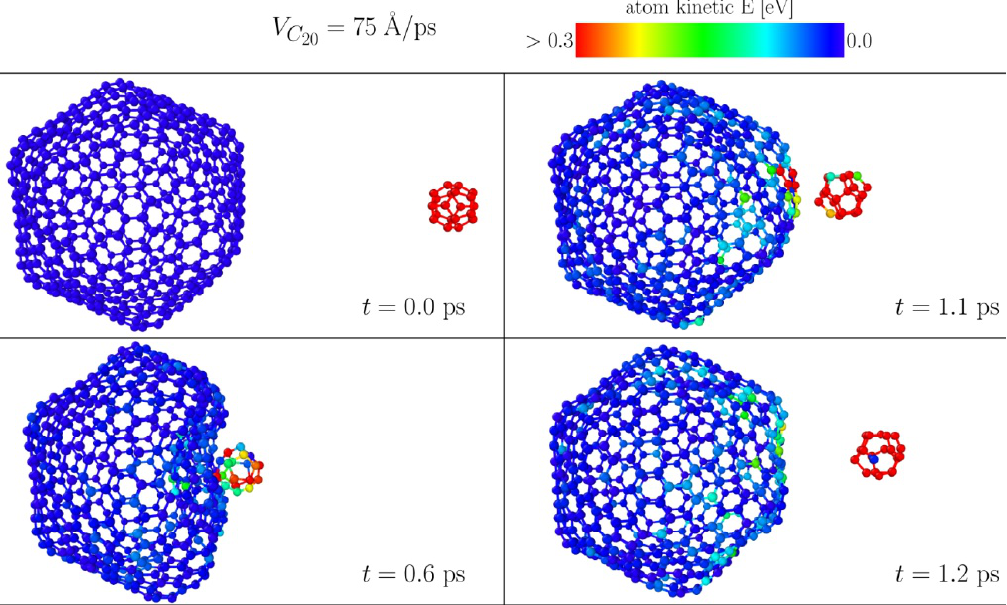
Fig. 4. Snapshots of the fullerene collision at the initial velocity V to the threshold value V =83 Å/ps above which structural changes appear in the C20